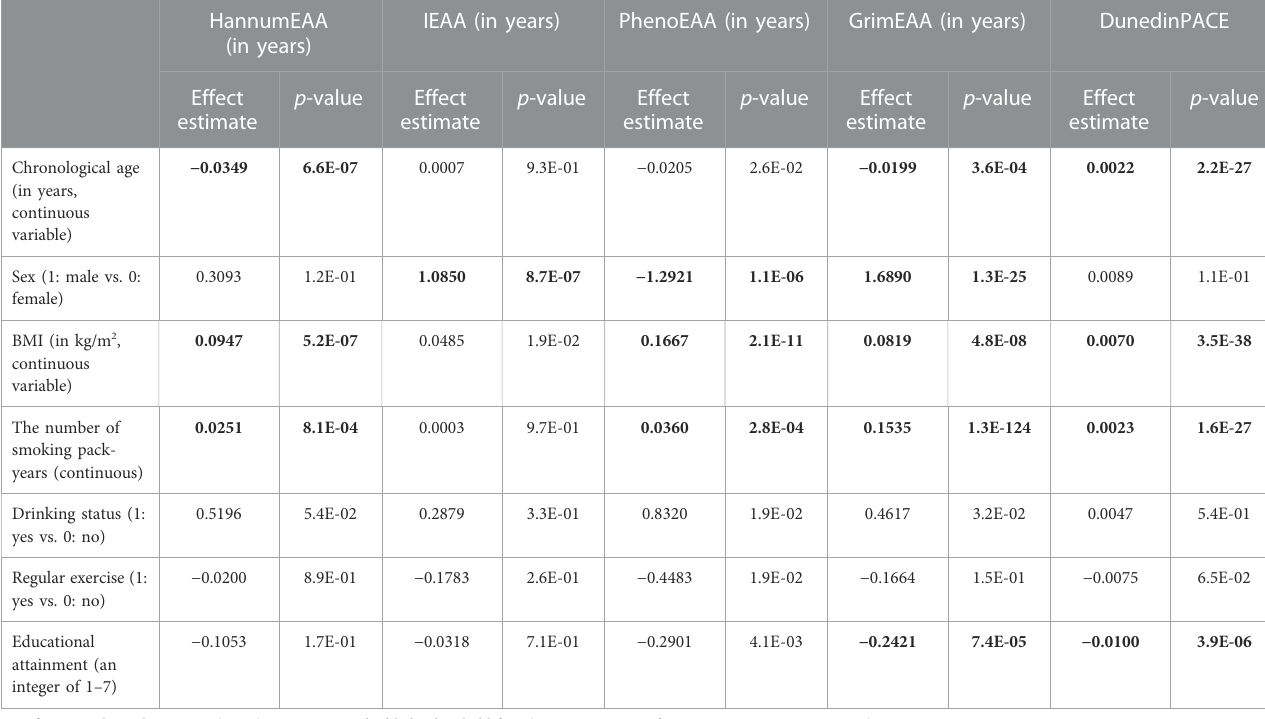
TABLE 3 Results of regressing each EAA on the seven main covariates (six cell-type proportions were also adjusted in the models). HannumEAA (in